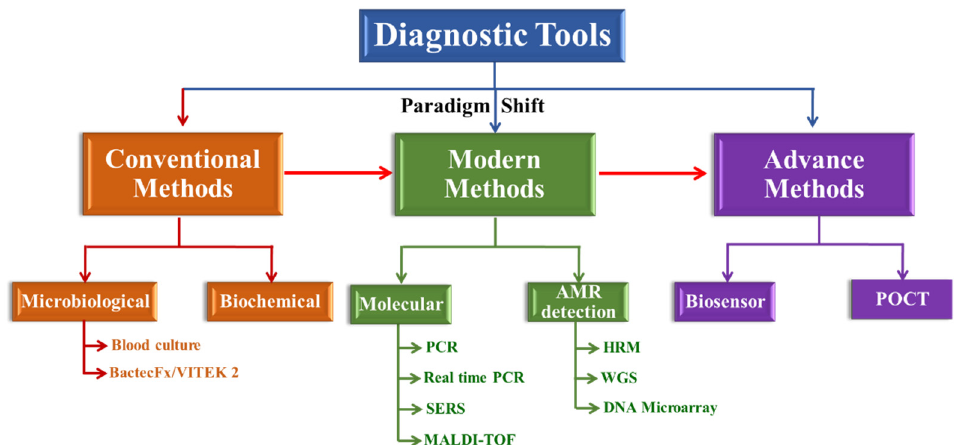
Figure 1. Schematic overview of the diagnostic methods. Conventional methods use the selected cultures and medium in traditional approaches and detect basic aspects of bacterial identification. Molecular detection uses molecular-based (DNA and RNA) approaches to identify resistance genes, as well as mutations in and expression of these genes, or their genomic signature.